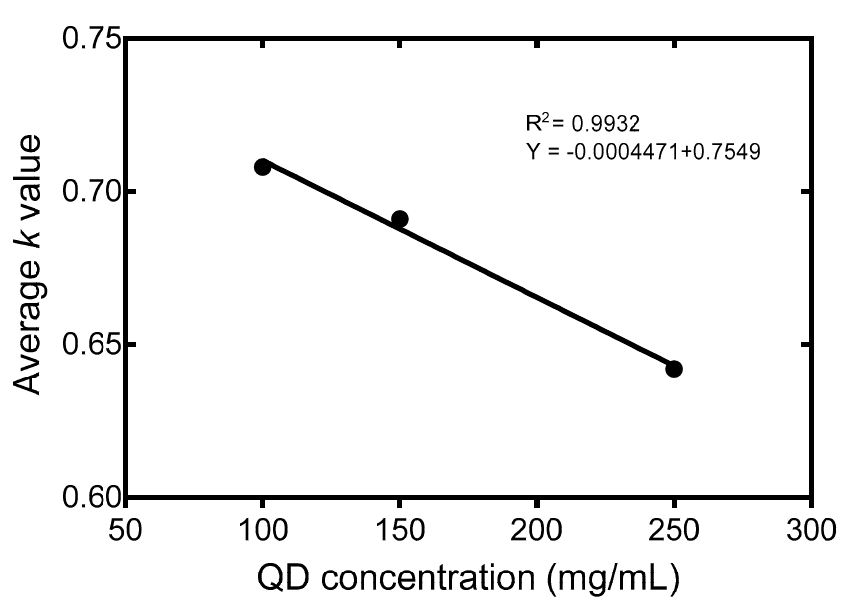
Figure 5. Effect of ZnCuInS/ZnS concentration on the k value.